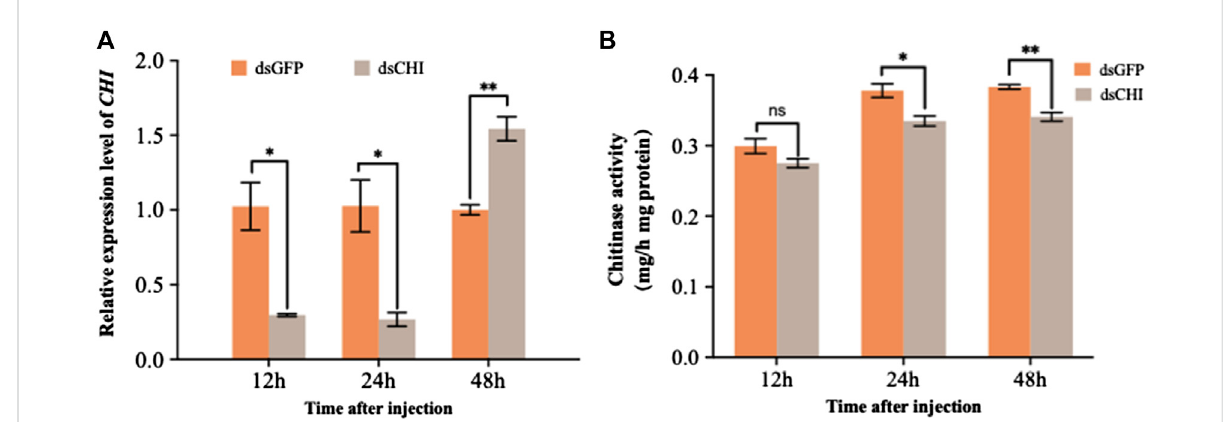
Changes in the expression and activity of chitinase after RNAi. Spodoptera frugiperda larvae at the fi rst day of the third instar stage were divided into three groups and injected with dsGFP and dsCHI, respectively. Insects were collected and used to determine the relative expression level of chitinase (A) and chitinase activity (B) at 12, 24 and 48 hafter dsRNA injection.Three replicates were performed per group. (Mean ± SE; t - test; ** p < 0.01, * p < 0.05, ns p >